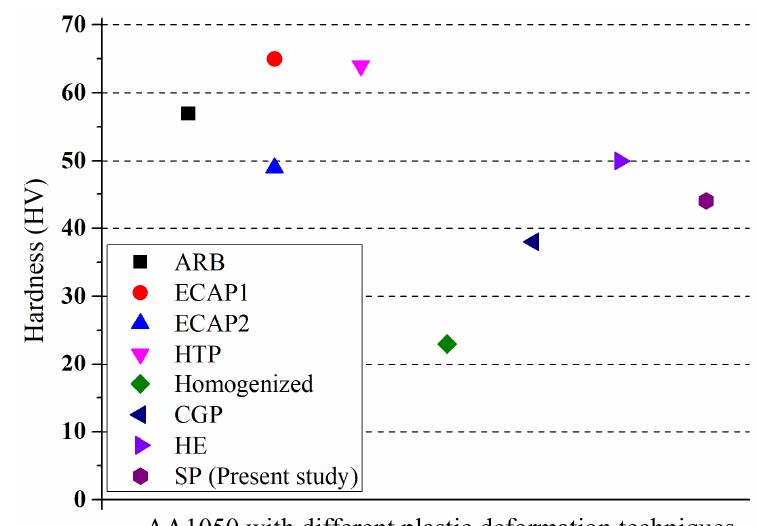
Figure 8. Comparison of obtained hardness values of AA1050 through ECAP1 [20], ECAP2 [77], HPT [31], ARB [17], CGP [71], HE [77], SP, homogenisation annealing.